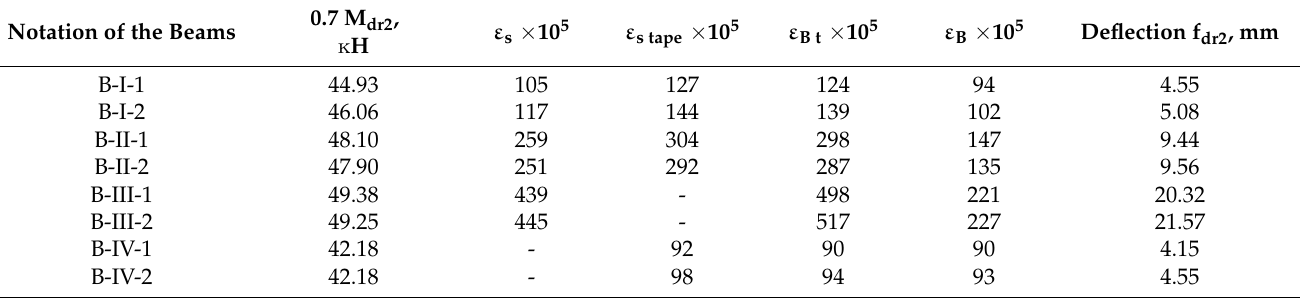
Table 5. The strain values in the cross-sections of the beams under loading of 0.7 M dr2 in zone of maximum bending